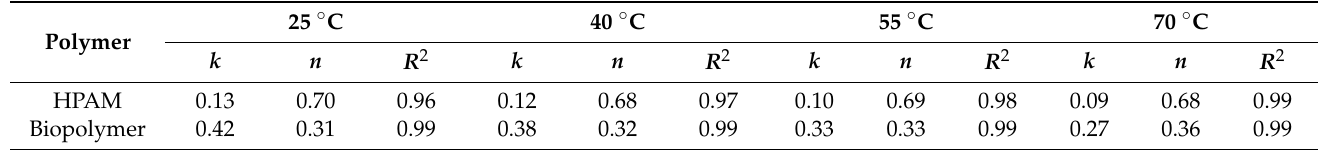
Figure 9. Shear viscosity variation as function of temperature at 10 s − 1 (2 wt% NaCl), Heating rate: 5 °C/min. Table 5. Effect of temperature on the shear viscosity of polymer systems.